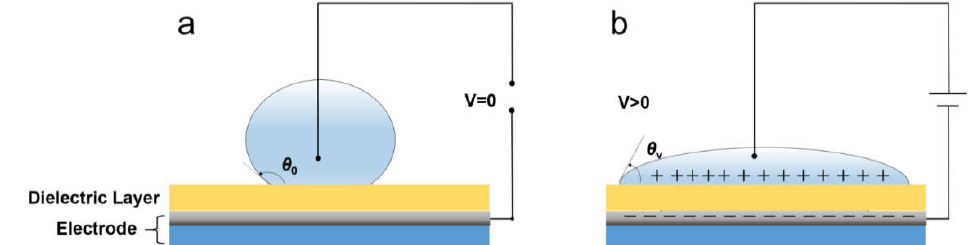
Figure 2. Schematic of the electrowetting on dielectric (EWOD) principle. ( a ) Initial condition of water droplet with no voltage applied. θ 0 is the initial water/air contact angle. ( b ) Water droplet shape and water/air contact angle ( θ V ) after voltage was applied.